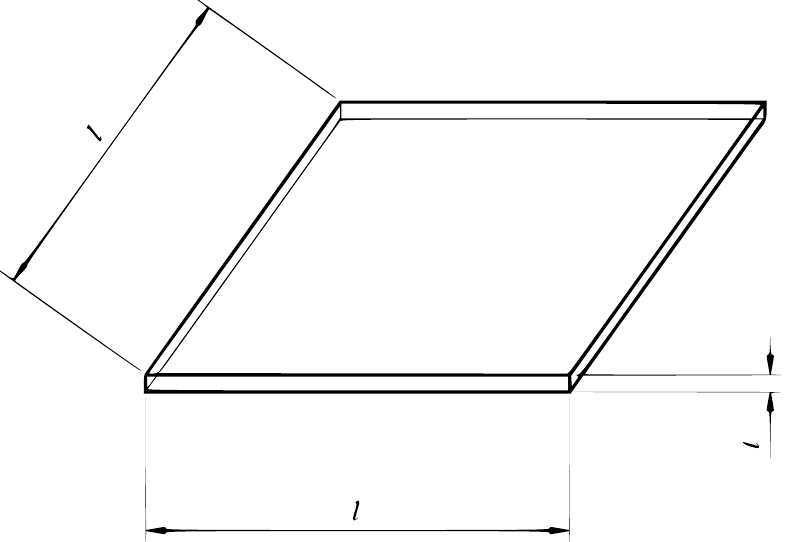
Figure 5. The domain of the bending-dominated piezoelectric plate.